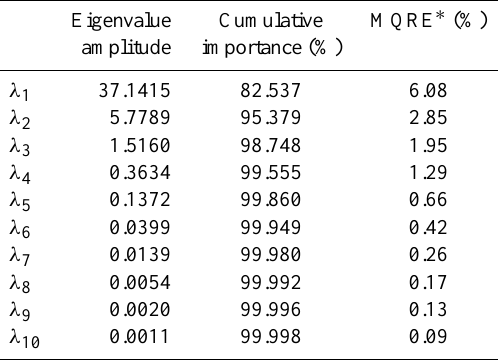
Table 2. PCA applied to the CIRA-86 pressure dataset. The eigen- values of the 10 first principal axes and their cumulative importance for capturing the overall dataset variability are given in the first two columns. The third column gives the total relative error made when the dataset is reconstruct by the use of the first PAs